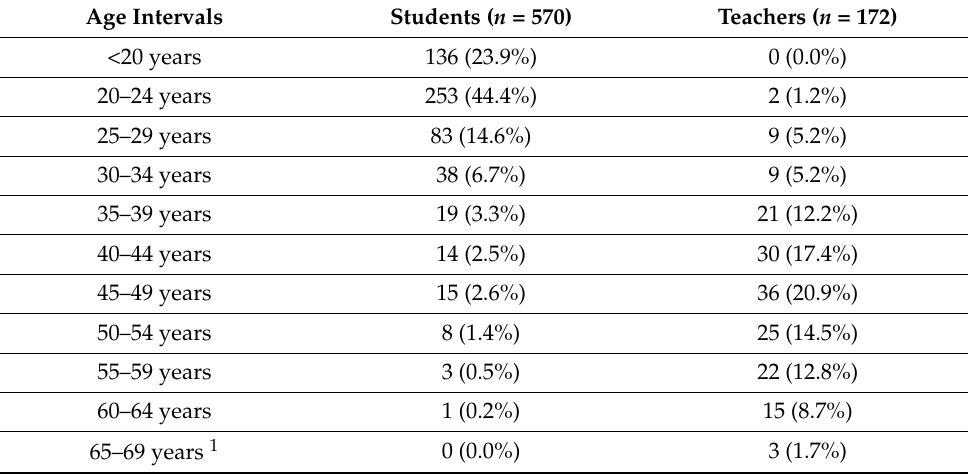
Table 5. Students and teachers, by